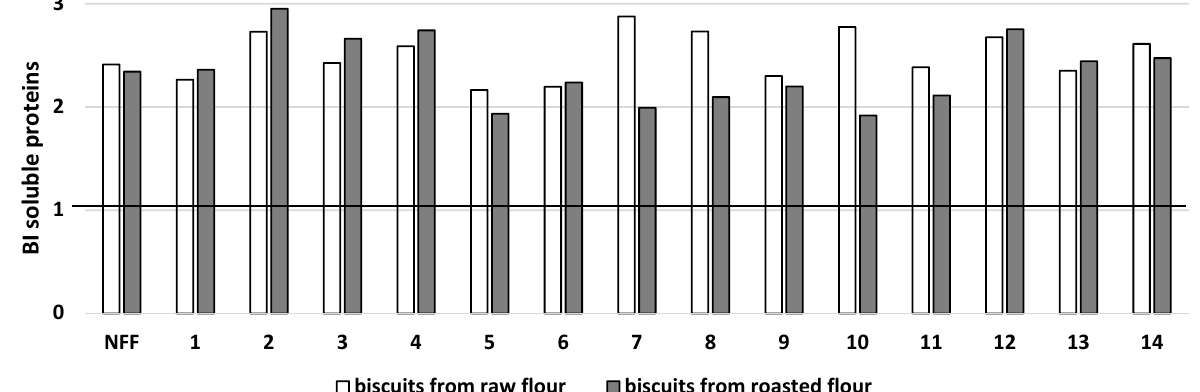
Figure 2. Potential bioaccessibility of soluble protein (BI soluble proteins) from buckwheat biscuits baked from raw or roasted buckwheat flour fermented by selected strains of lactic acid bacteria. NFF—nonfermented flour. Flours fermented by: 1 —Lactiplantibacillus plantarum IB; 2—